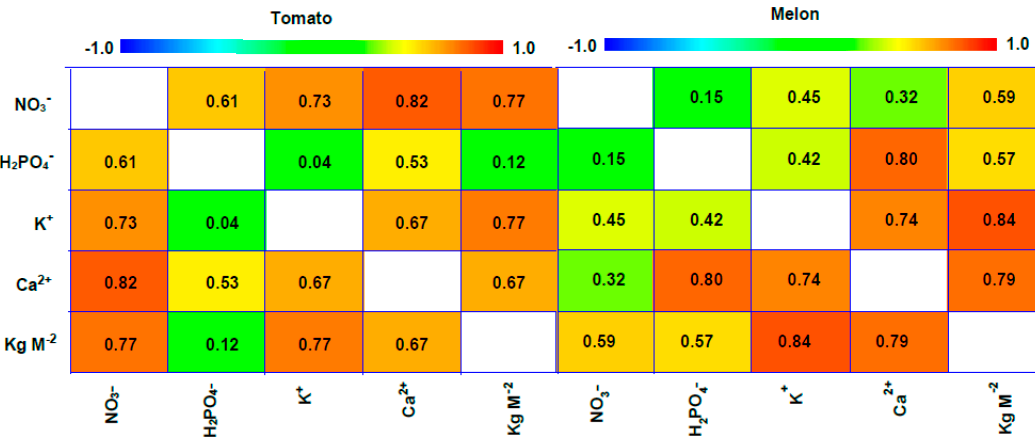
Table 9. Petiole cellular extract analysis for the melon crop (mg L − 1 .). DAT, days after transplant.